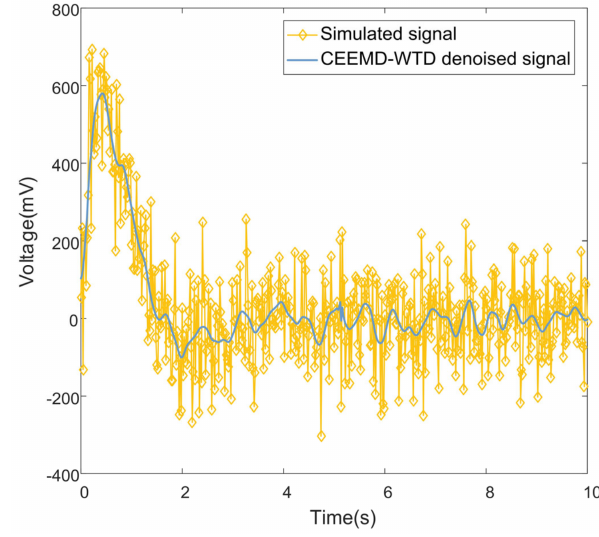
Figure 12. Simulated signal before and after CEEMD-WTD denoising.